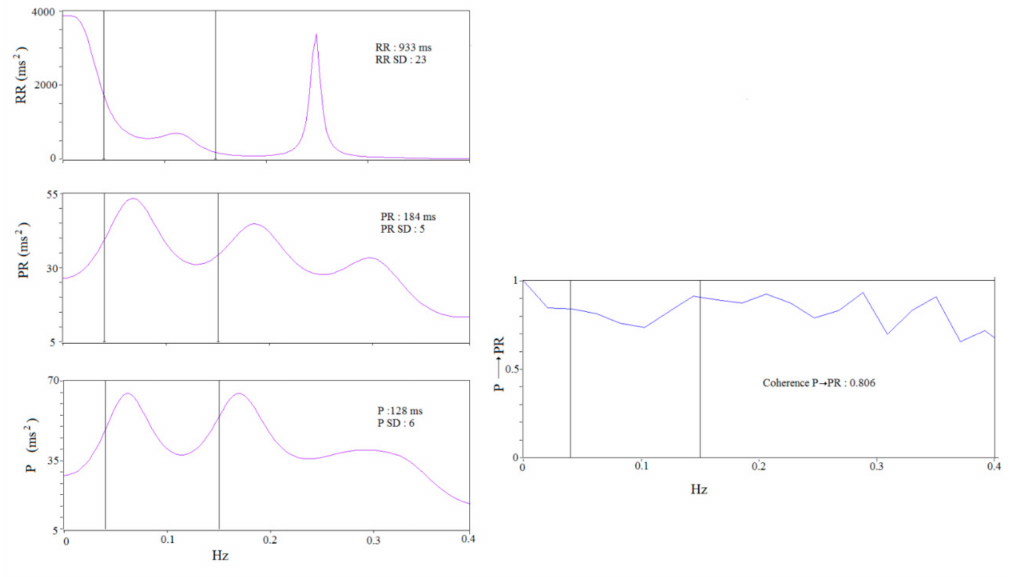
Figure 4. On the left panel the power spectral analysis of RR, PR and P intervals (recording in the Figure 3); on the right panel the spectral coherence (P → PR) of two